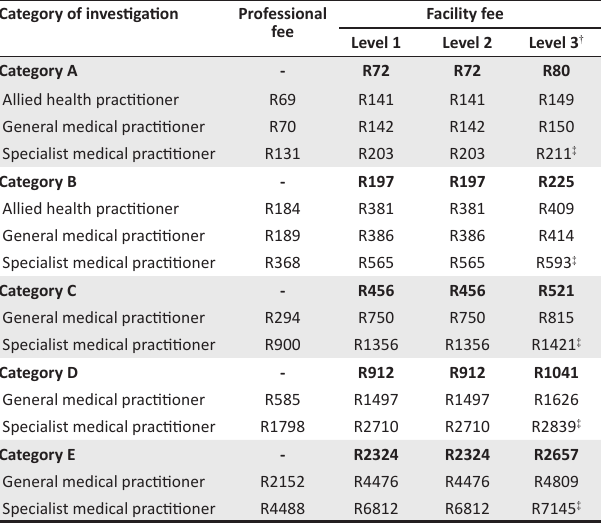
TABLE 1: 2017 Uniform patient fee schedule imaging